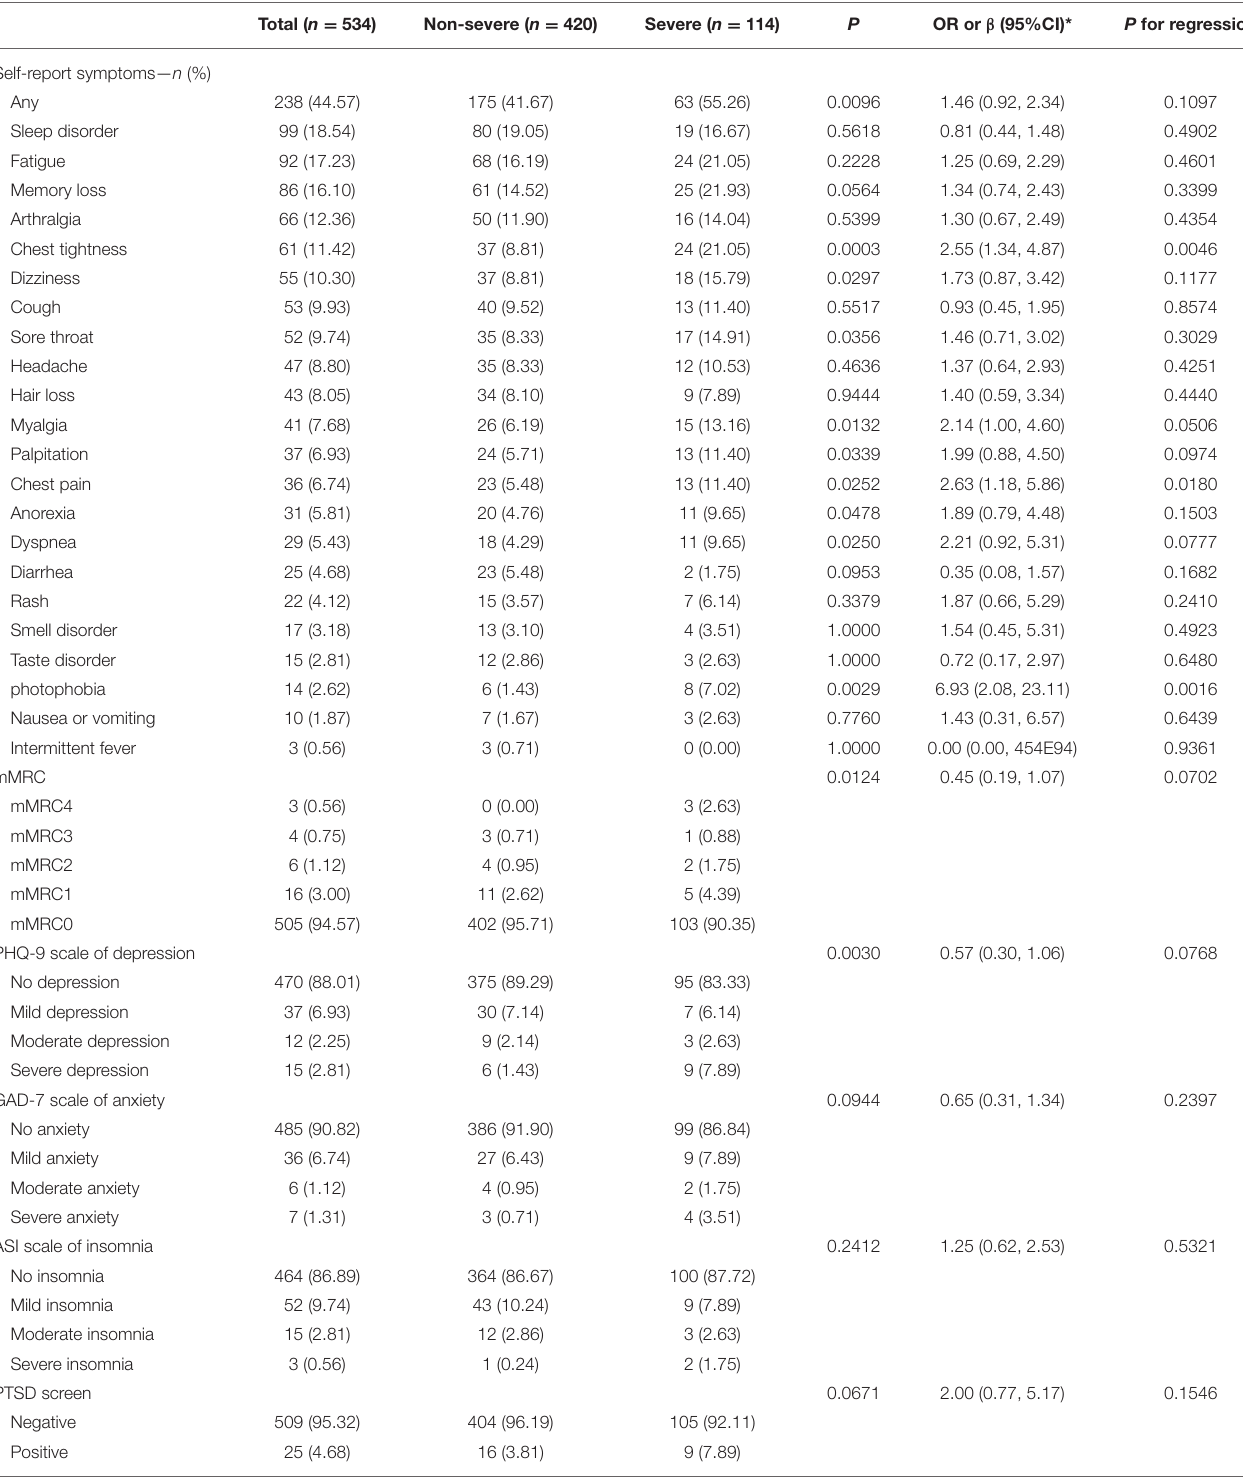
TABLE 2 | Persistent symptoms and psychological consequences at 15-month follow-up. Total ( n = 534) Non-severe ( n = 420) Severe ( n = 114) P OR or β (95%CI)* P for